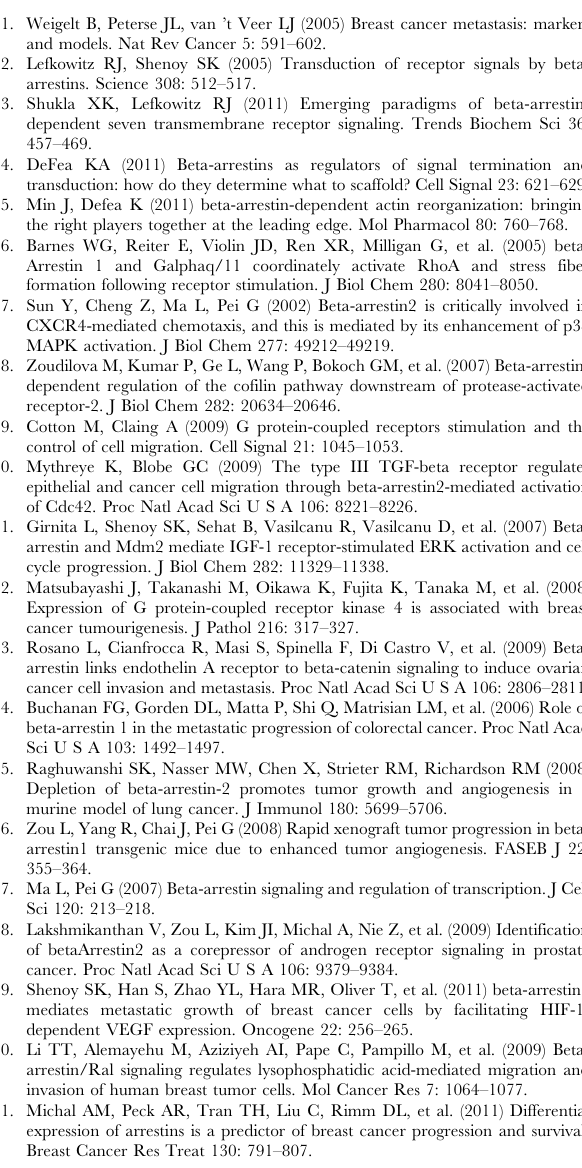
Figure S2 Effect of Rap1A depletion on MDA-MB-231 cell adhesion. MDA-MB-231 cells stably expressing scrambled shRNA or Rap1A shRNA were subjected to adhesion assays to fibronectin. Columns show % adhesion compared to scrambled control; data from four independent